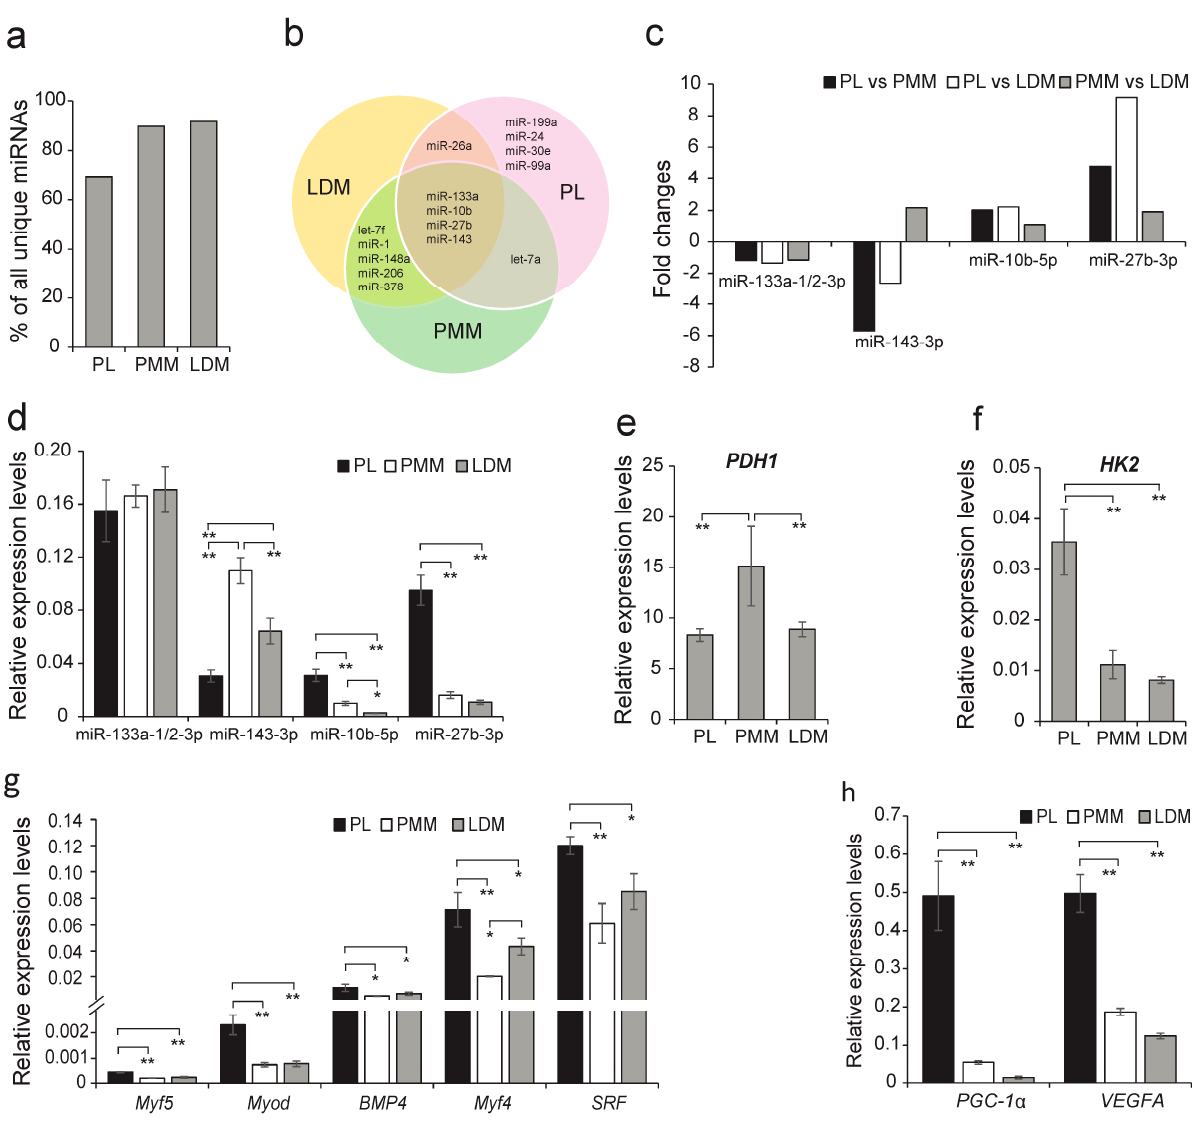
Figure 2. Analysis of miRNAs universally abundant across the three muscles. ( a ) The top 10 miRNA reads as a percentage of total unique miRNAs; ( b ) Distribution of the top 10 miRNAs in each muscle; ( c ) Fold change of miRNAs abundantly expressed in all three muscles. The relative expression levels, measured by qRT-PCR, of: ( d ) miRNAs shown in ( c ); ( e ) HK2 ; ( f ) PDH1 ; ( g ) myogenic regulatory factors; and ( h ) angiogenesis-related genes. Data are means ± SD. Statistical significance was calculated by one-way